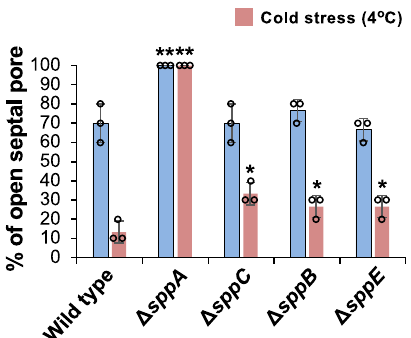
apicalsepta in each experiment. Three independent experiments were performed, and the percentage of open septal pore is shown on the Y axis. The data are pre- sented as the mean of replicate experiments, and error bars represent standard deviations. Statistical signi fi cance was tested using two-tailed Student ’ s t test: *P <0.05, **P <0.01. Source data are provided as a Source Data fi